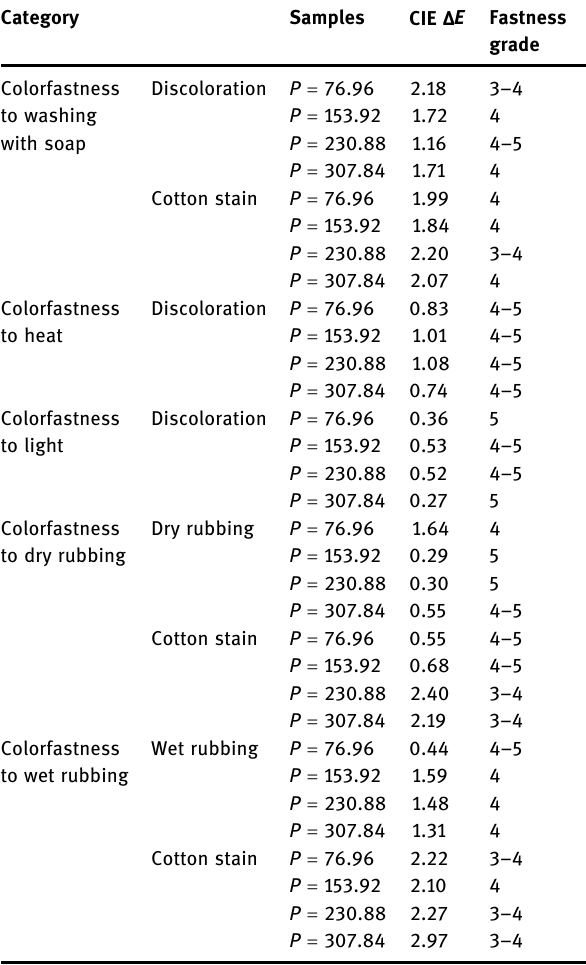
Table 3: Colorfastness of the spun - dyed fi ber under di ff erent conditions